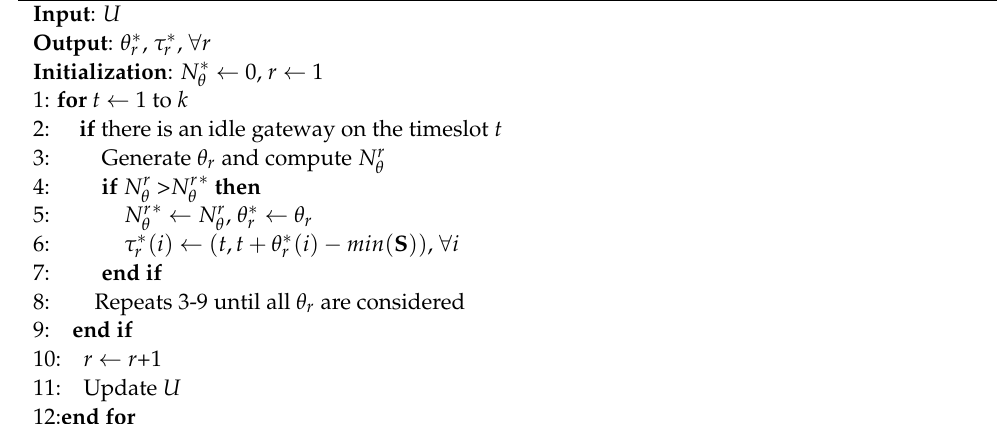
Algorithm 1. Resource Allocation Algorithm for GACK